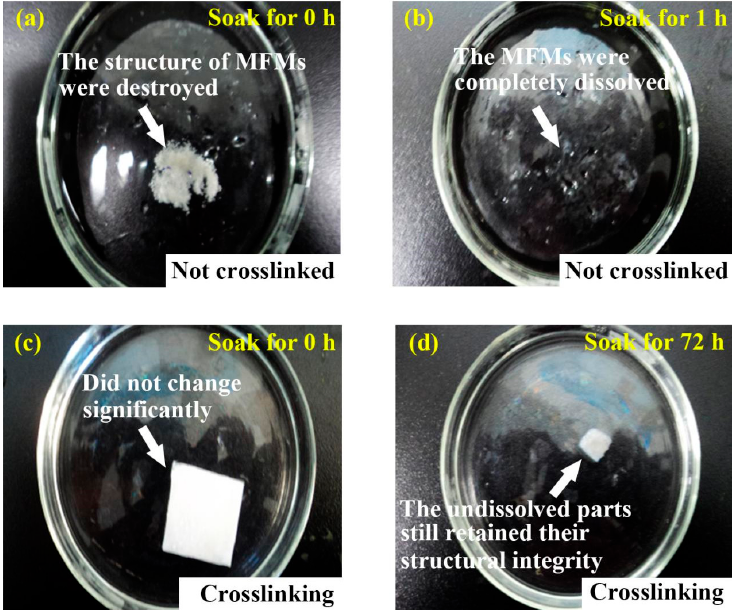
Figure 7. Water dissolution resistance of non-crosslinked SA/PVA/PEO 5:3:2 MFMs ( a ) soaked for 0 h, and ( b ) soaked for 1 h. Water dissolution resistance of crosslinked SA/PVA/PEO 5:3:2 MFMs with CaCl 2 ( c ) soaked for 0 h, and ( d ) soaked for 72 h.